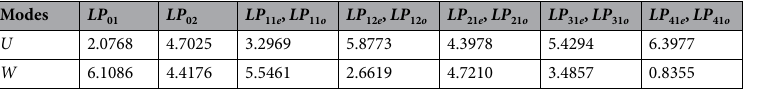
Table 2. The values of U and W for the LP modes that the LMA fiber used for the demonstration can